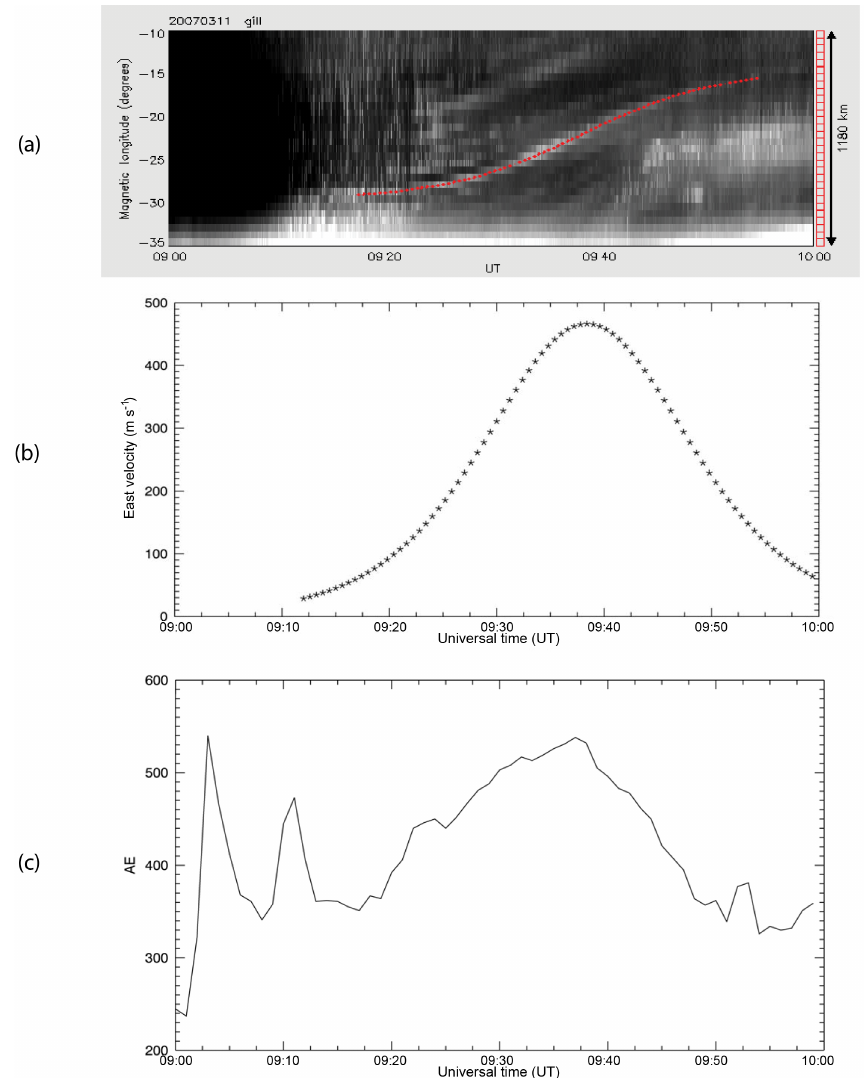
Figure 5. (a) The 1h ewogram from 09:00 to 10:00UT on 3 November 2007. The red curve is the tanh fitting result of the curve line in the ewogram. (b) Velocities derived from the fitting result in (a) with respect to universal time. (c) One-minute AE index from 09:00 to